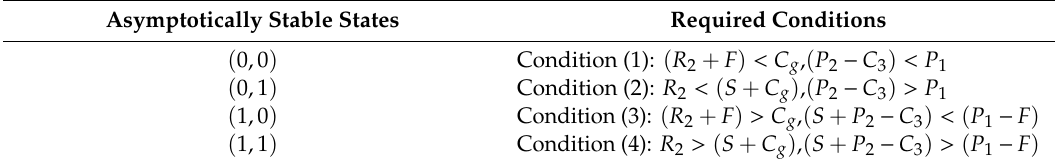
Table 4. The asymptotically stable states and their required conditions.